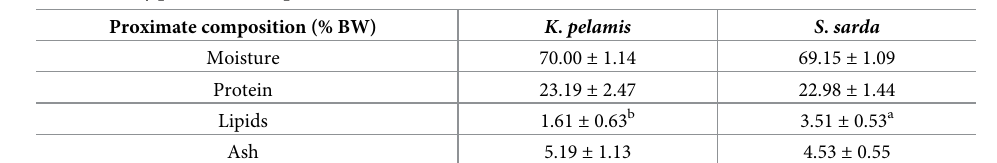
Table 3. Body proximate composition.